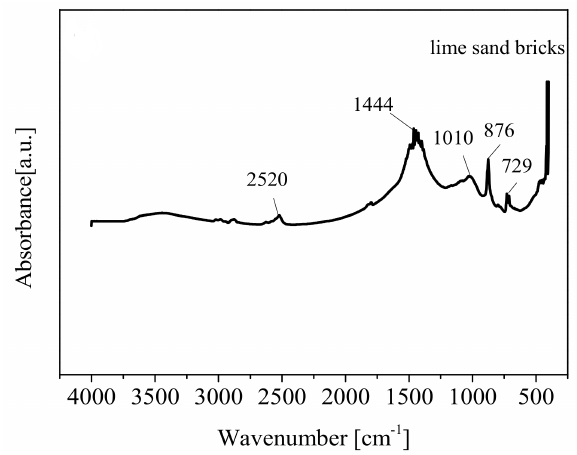
Figure 3. The Fourier transform infrared spectroscopy (FITR) spectra of lime sand bricks. Table 2. The major elements’ contents (oxide%) in lime sand bricks measured by X-ray fluorescence (XRF). Composition